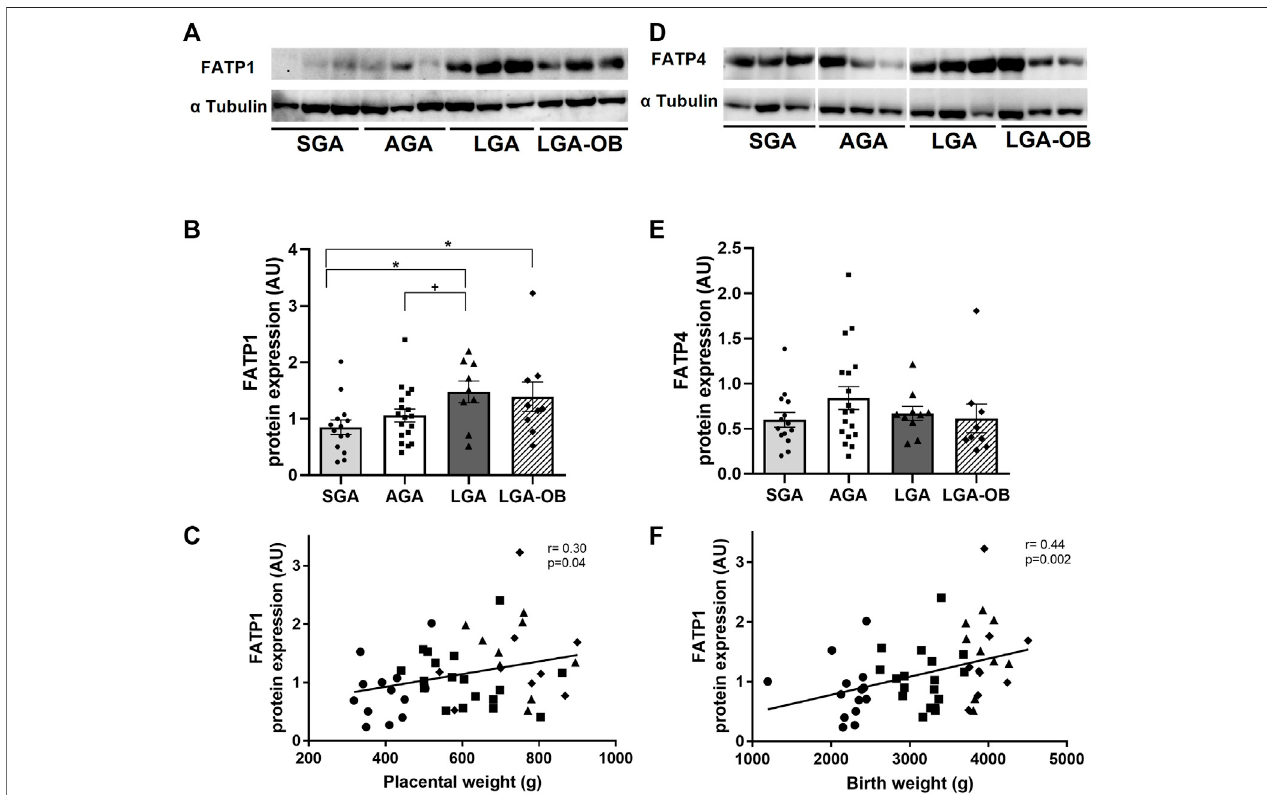
FIGURE 3 | Protein expression of fatty acid transporters in placentas of SGA, AGA, LGA, and LGA-OB newborns. Representative Western blot of FATP1 (A) and FATP4 (D) inplacentasofSGA(n=14),AGA(n=18),LGA(n=10),andLGA-OB(n=9)newborns.Bandspresentedcorrespondtothesamemembrane.Quanti fi cation ofFATP1 (B) andFATP4 (E) proteinexpressionsintheplacentabyimmunodetection.Dataaremean±SE.*denotessigni fi cantdifference( p < 0.05)betweengroupsby ANOVA.+denotessigni fi cantdifference when compared tocontrolAGAbyStudent´s t test. Correlationbetweenthe placental expression ofFATP1 withplacental weight (C) and birth weight (F)